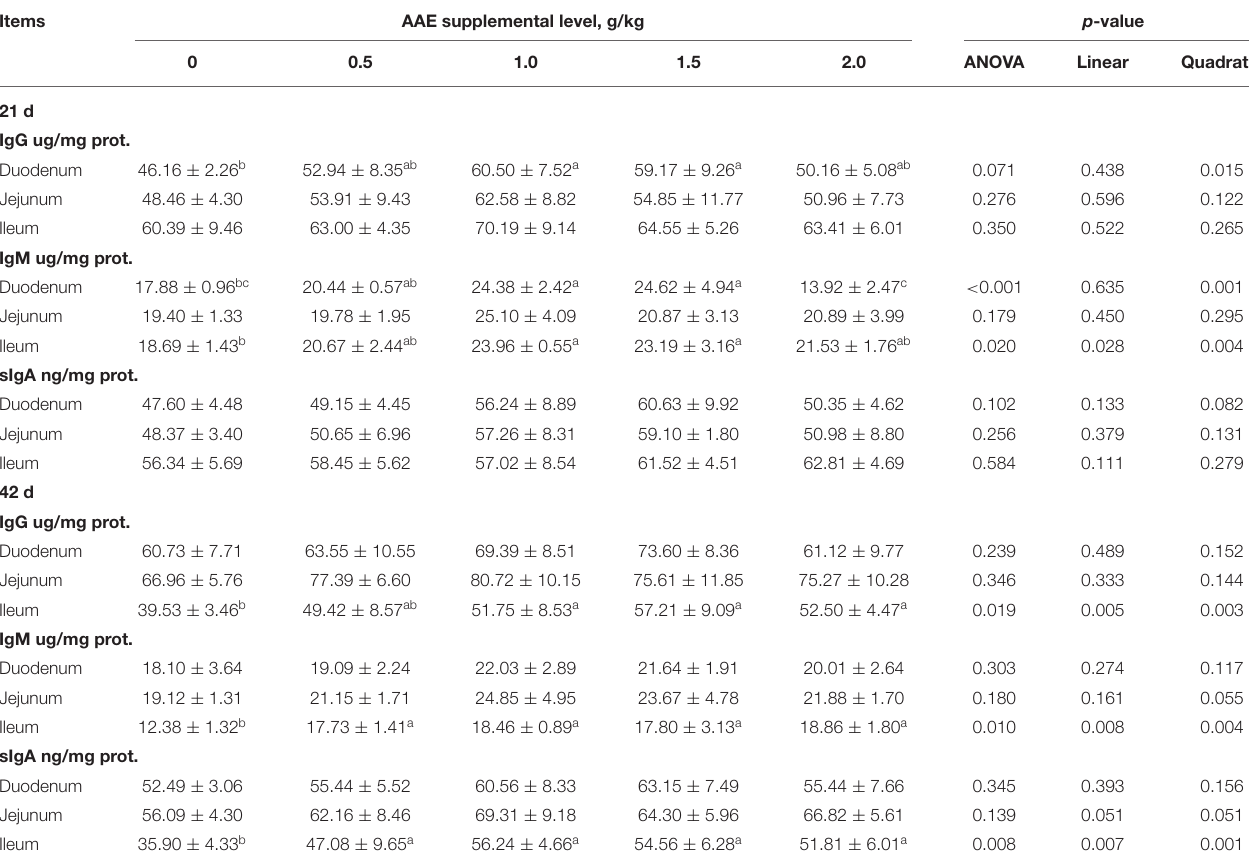
TABLE 5 | Effect of AAE on immunoglobulin content in small intestine of broilers.